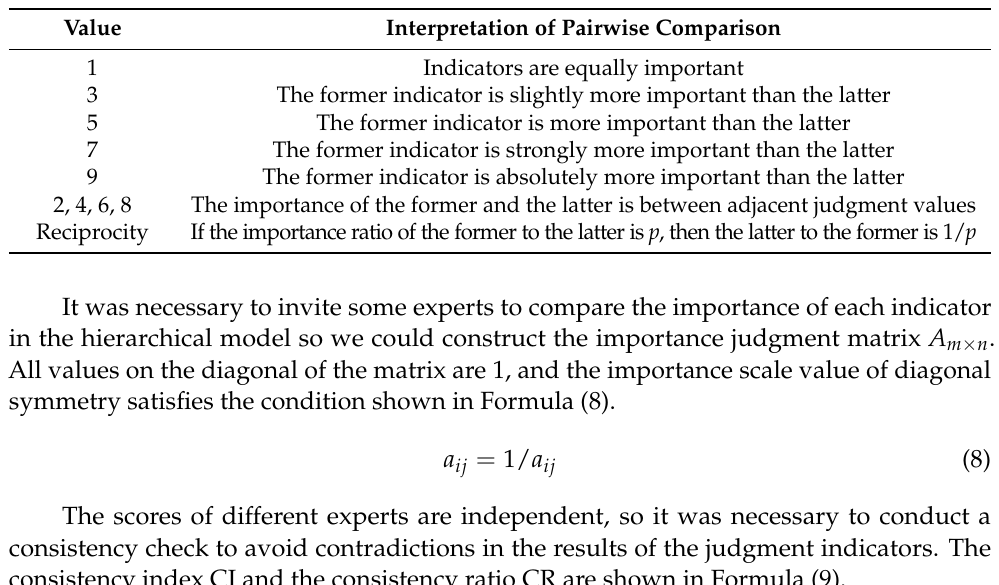
Table 1. Interpretation of judgment